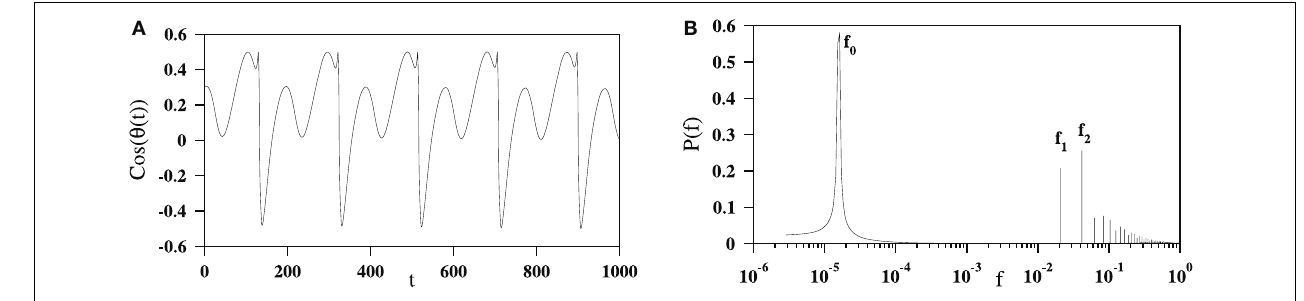
f 0 = 1 /( 4096 L ) , f 1 = 1 /( 3 L ) , and f 2 = 2 /( 3 L ) . The higher frequencies can be expressed as combinations of the f 1 and f 2 and essentially become harmonics of f 1 since f 2 = 2 f 1 .